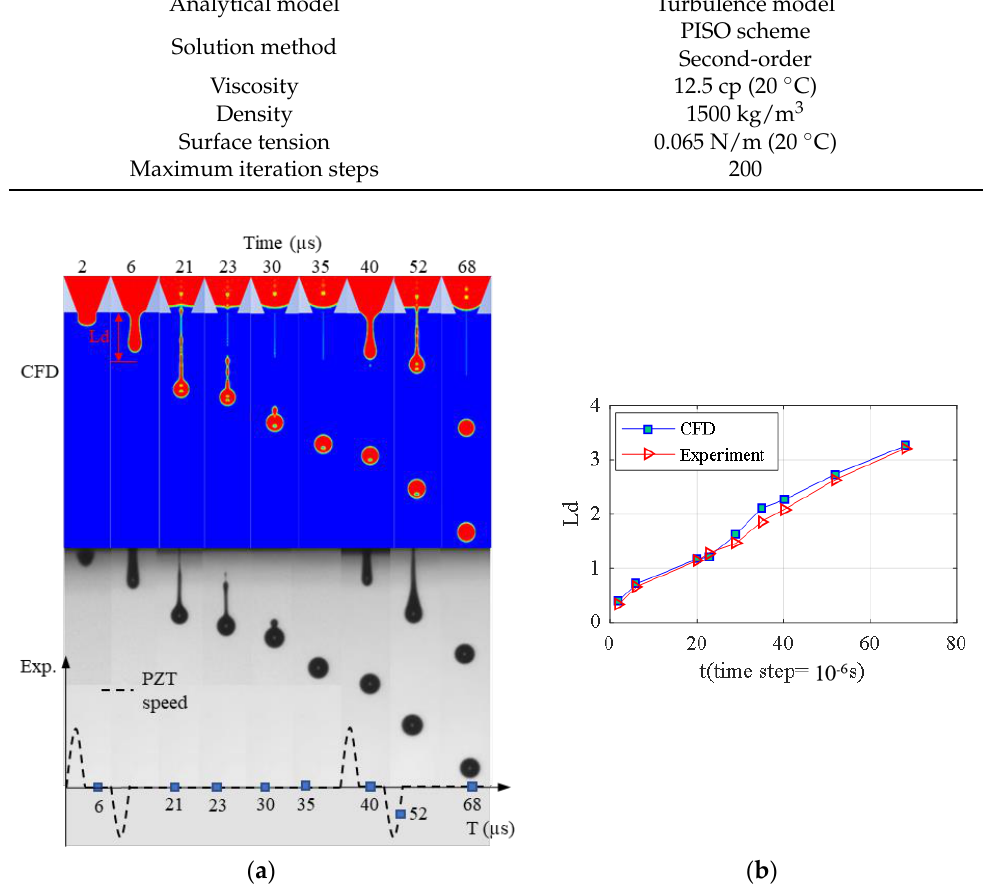
Figure 6. Comparison of CFD model and experimental results. ( a ) Comparison of droplet morphology between CFD model and experiment. ( b ) Comparison of the droplet length (which is normalized to the range from 0 – 1) between the CFD simulations and the experimental tests.